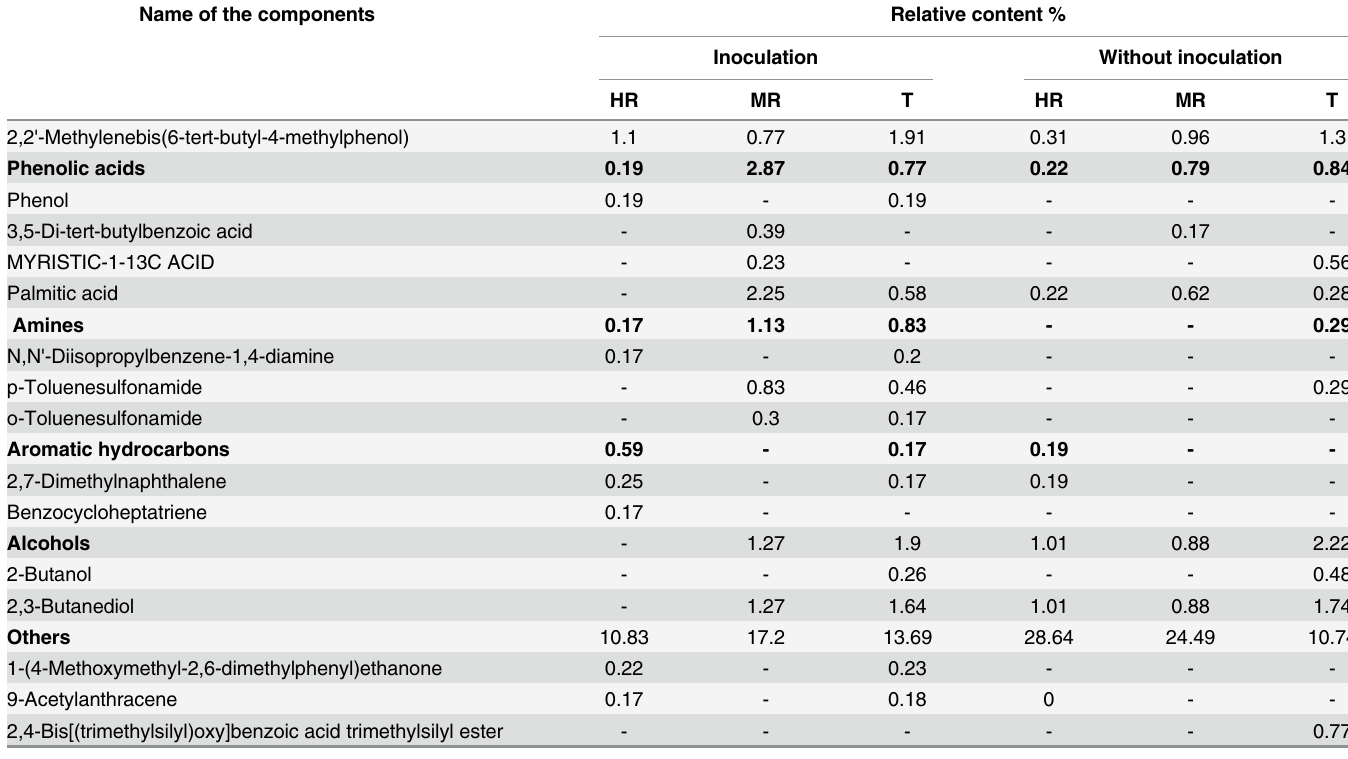
Effects of simulated components on M . incognita J2 survival. The four exudate com- pounds all increased the mortality rate of M . incognita J2, but large differences were observed between the different concentrations (Fig 5; S2 Table). At 24 hours, the corrected mortality rates of J2 were highest with the 1mmol (cid:1) L -1 of 2,6-Di-tert-butyl -p-cresol (A), L-ascorbyl 2,6-dipalmitate (B) and dibutyl phthalate (C) respectively. However, the corrected mortality rate at 2 mmol (cid:1) L -1 of dimethyl phthalate (D) was significantly higher than the other com- pounds (P < 0.01). The corrected mortality rates of J2 followed a similar trend at 48 hours. The corrected mortality rate at 2 mmol (cid:1) L -1 of dimethyl phthalate (D) increased from 29.42% up to 87.16%. Effects of simulated components on chemotaxis of M . incognita J2. As shown in Table 3, only dibutyl phthalate (C) repelled M . incognita J2. All the other compounds were associated with a neutral response. The chemotaxis factor (Cf) value of 2,6-Di-tert-butyl-p-cre- sol (A) and CK were above 1.5 and the Cf values of the other compounds were below 1 (except for L-ascorbyl 2,6-dipalmitate at the 2 mmol (cid:1) L -1 ). The ascending order according to the Cf value was C < B < D < CK < A. Effects of simulated components on the disease index of tomato cv. L-402. The four compounds were all associated with a reduction of the disease index of L-402 tomato seedlings (Fig 6; S3 Table) which decreased as concentration increased. Seedlings irrigated with L-ascor- byl 2,6-dipalmitate (B) at the highest concentration (2 mmol (cid:1) L -1 ) showed the best resistance